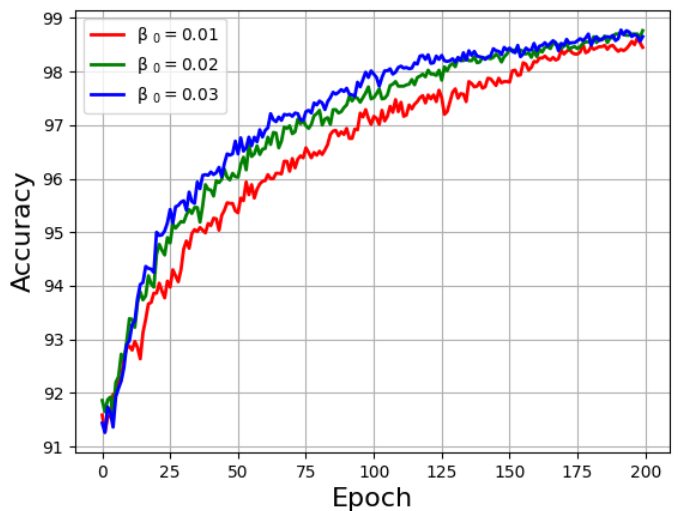
Figure 7. Training behaviors of the ICSR technique for different values of the free parameter β 0 on SLT-10 clustering models from SPICE. It is seen that for different selections of the value β 0 , training will converge to almost the same state after 200